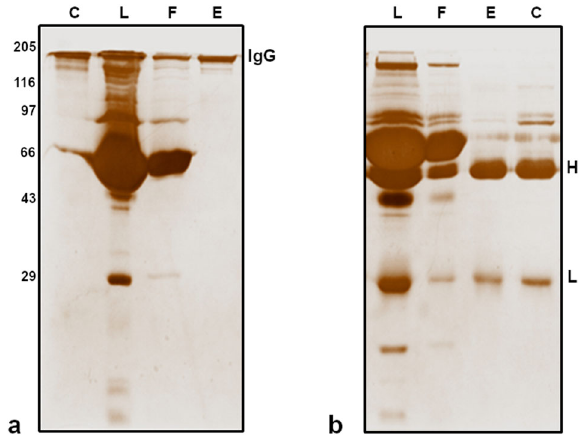
Fig. 2 SDS-PAGE (10%) analysis. a Non-reducing conditions, b reducing conditions. Lanes: C-human IgG, Cohn fraction (II, III), L-total serum, F- fl ow-through and E-elution (0.2 M NaCl). H and L correspond to heavy chain (50 KDa) and light chain (25 KDa) of IgG. Gels were derived from the same experiment.